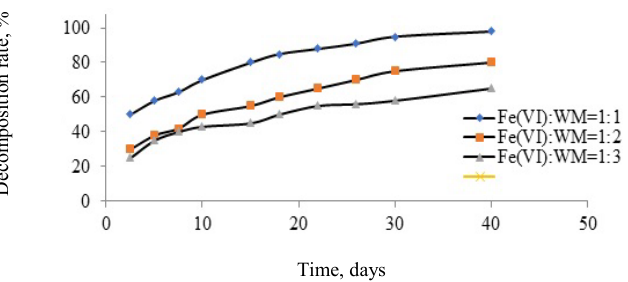
Fig. 6. Dependence of the degree of decomposition of encapsulated sodium ferrate on the duration of their exposure to air. The degree of decomposition of encapsulated sodium ferrate increases as the length of time that the capsules stay in the air increases; at the same time, the increase in weight of the capsule shell reduces the degree of decomposition of ferrate, ceteris paribus. Thus, encapsulated sodium ferrate with a three-fold excess of the mass of the capsule shell over the ferrate retains its stability by 40 % after 40 days of exposure to air.